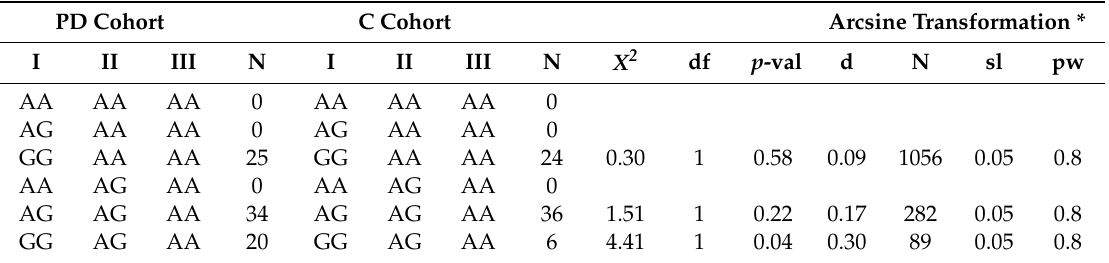
Table 4. The equality of population proportions of a joint genotype in PD patients and in controls: various genotypic combinations in the triplets of A1